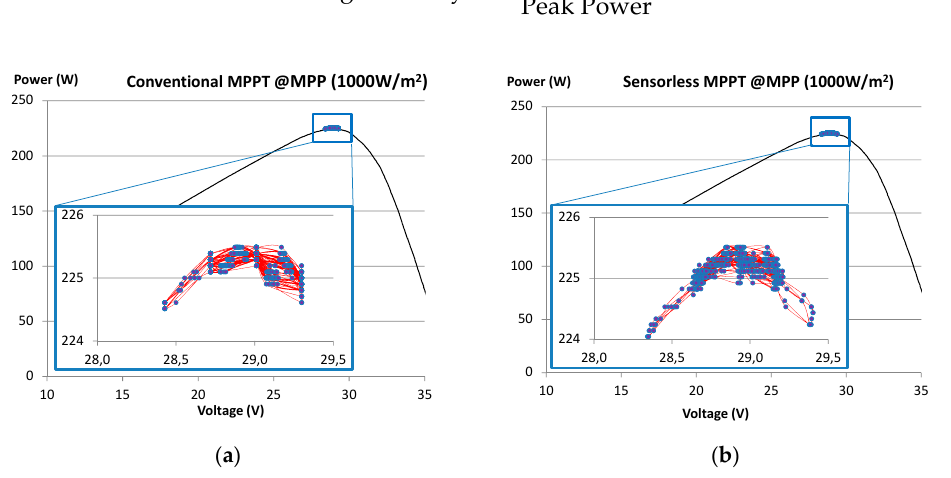
Figure 18. Dispersion of the operation point near the MPP. Total test time: 50 s. F MPPT = 10 Hz. ( a ): Conventional, V PV step: ∆ V PV_Ref = 300 mV. ( b ): Sensorless, PCC Vc step: ∆ Vc = 12.5 mV ( ≈ 250 mA near the MPP). Table 4. Performance of the MPPT algorithms at the MPP under constant irradiation (1000 W/m 2 ).